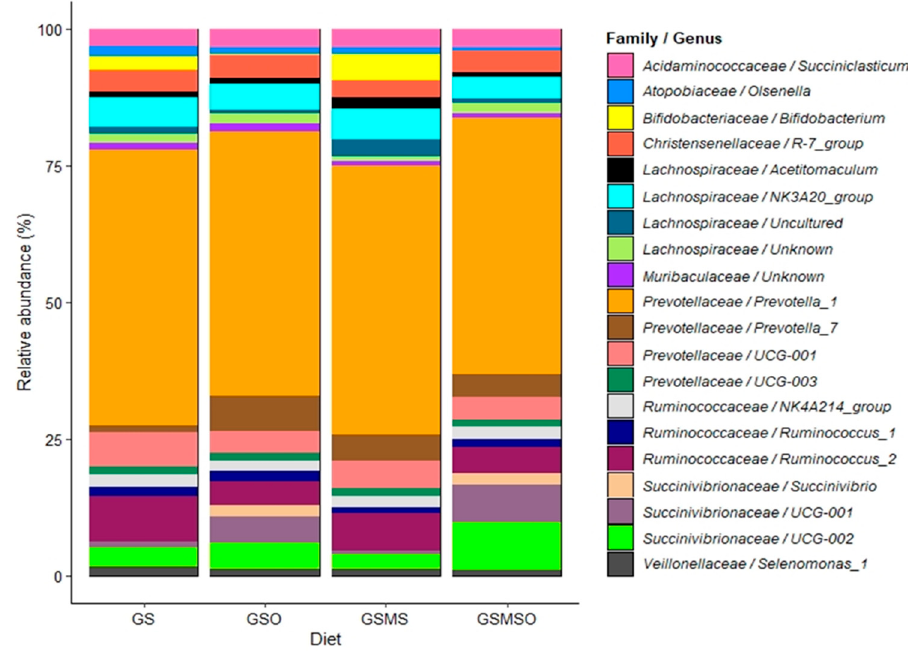
Figure 3. Bacteria family and genus composition in rumen fluid, shown as mean percentage relative abundance for each experimental diet: GS—grass silage; GSO—grass silage with rapeseed oil sup- plementation; GSMS—grass silage plus maize silage; GSMSO—grass silage plus maize silage with rapeseed oil